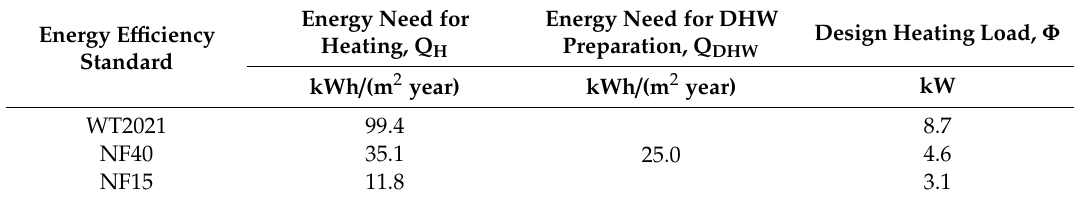
Table 6. Energy need for heating and DHW preparation for the WT2021, NF40 and NF15 standards. Energy E ffi